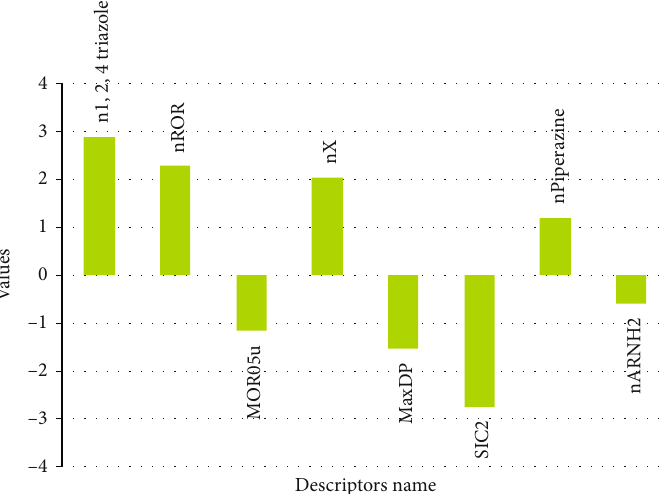
Figure 1: Importance of the descriptors entered in the GA-PLS